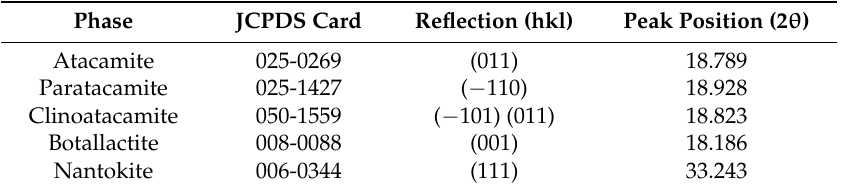
Table 2. Position of the strongest peak of the most common copper chlorides for Co